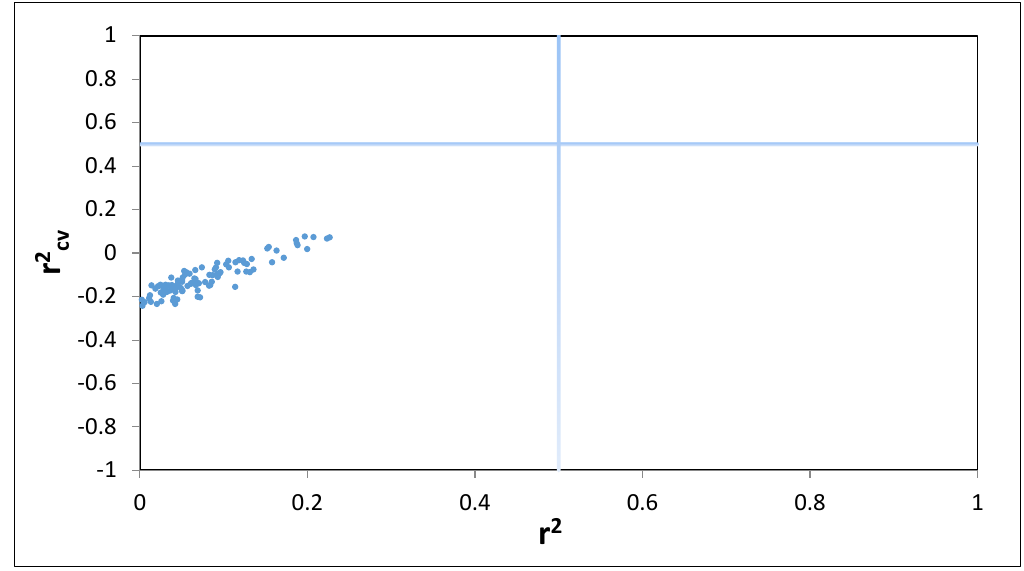
Figure 2. y-Randomization plot of stepwise MLR